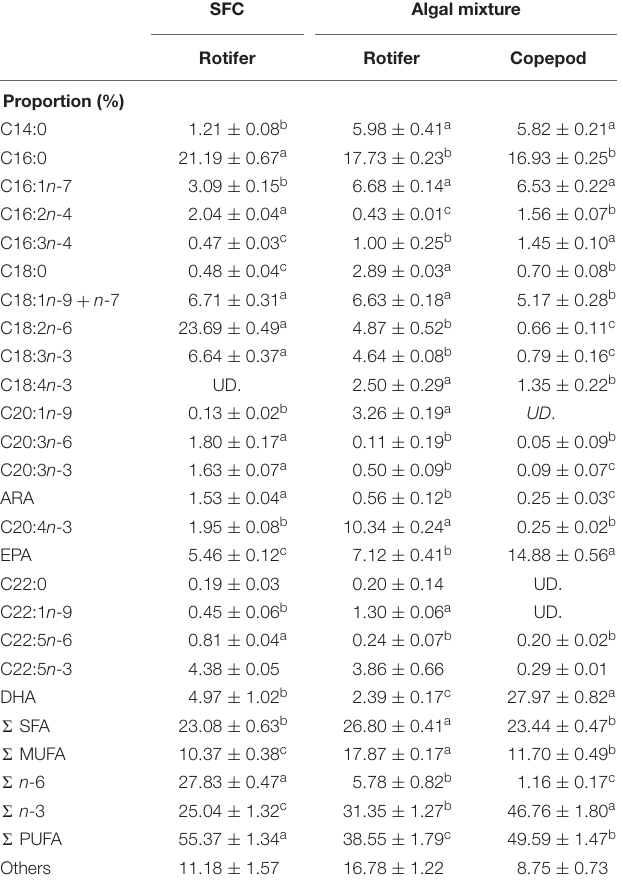
TABLE 4 | Fatty acid proportions in polar lipids of preys enriched with docosahexaenoic acid-supplemented Super Fresh Chlorella (SFC), or algal mixture.